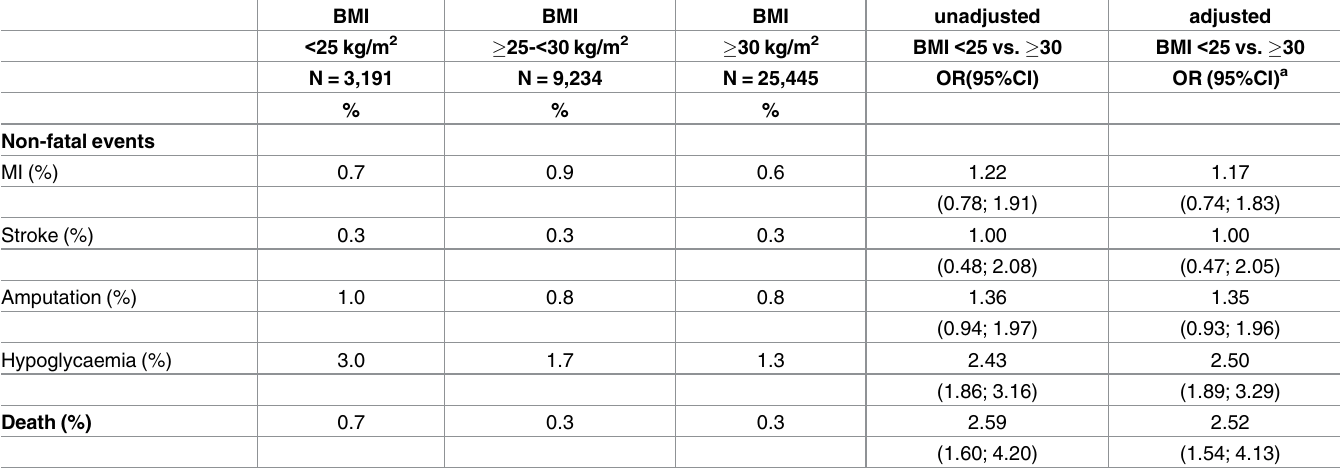
Table 4. Events during the most recent treatment year in patients with lean versus obese type 2